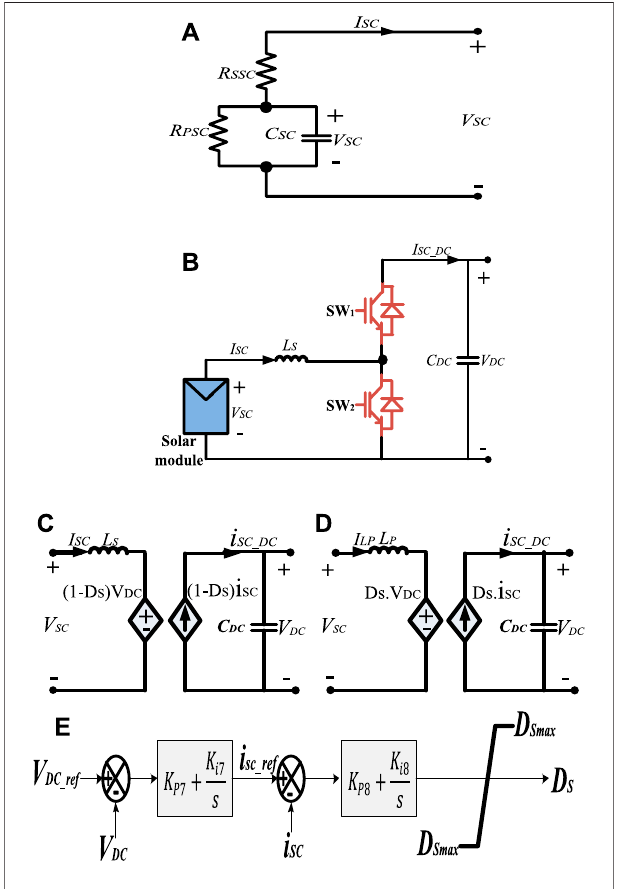
FIGURE 6 | (A) Equivalent circuit of an SC, (B) DC-DC converter comprises two switches (SW 1 and SW 2 ), (C) simpli fi ed structure, (D) Framework of a back-to-back DC-DC converter. (E) Control structural layout of the DC/DC converter topology for SC.